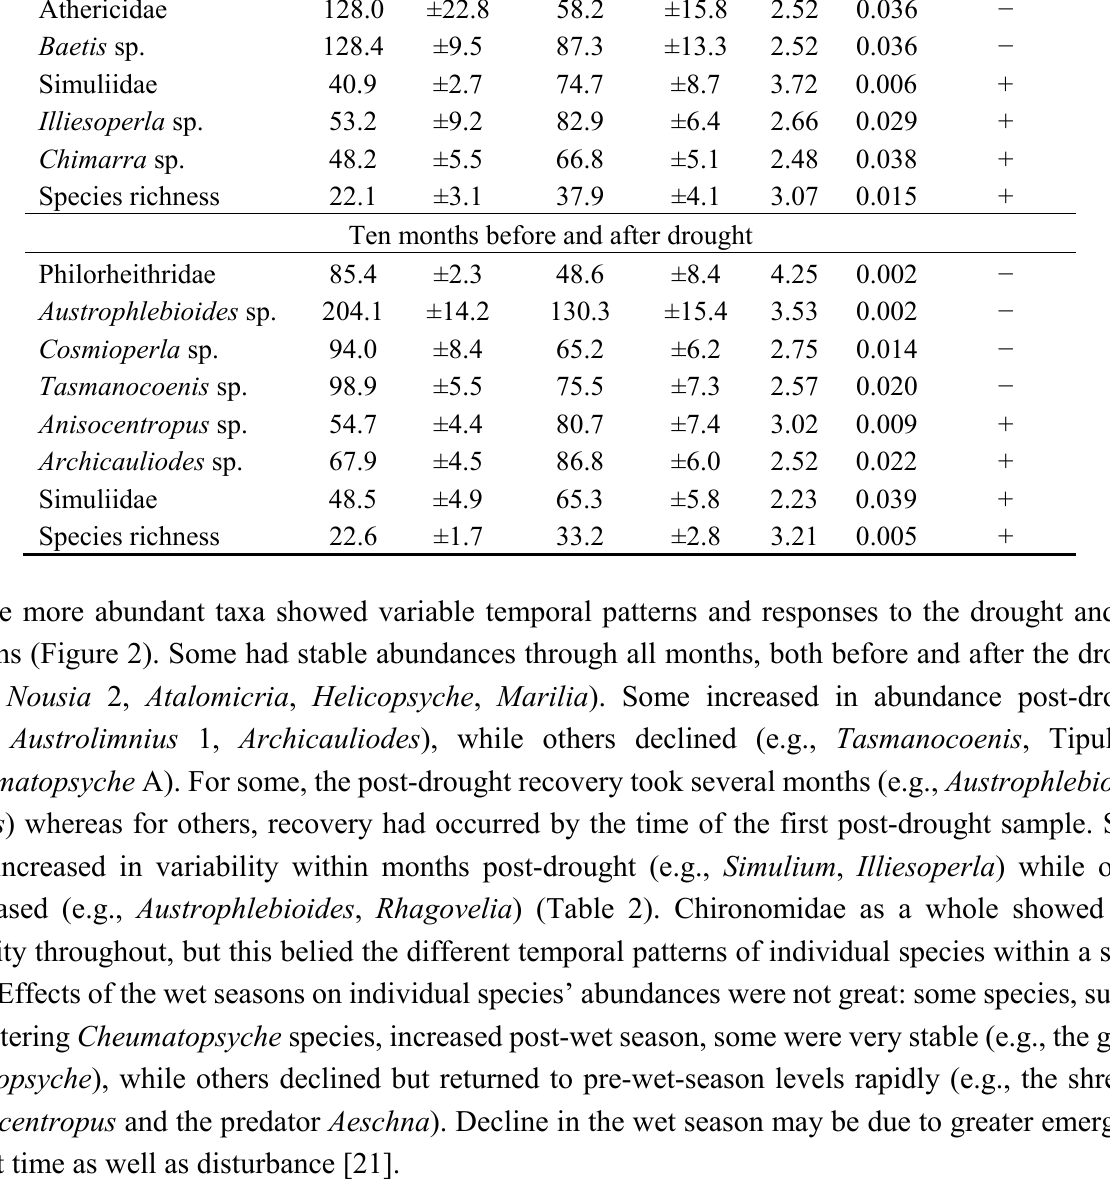
Ten months before and after drought